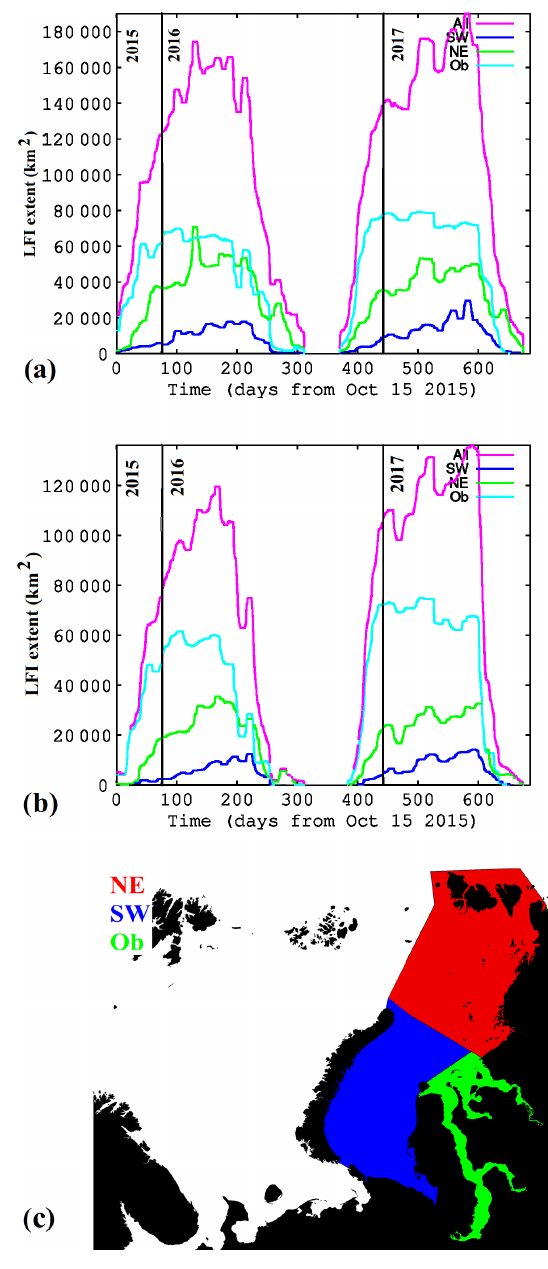
Figure 10. FMI-A (a) and FMI-B (b) LFI time series for the whole study period from 15 October 2015 to 31 August 2017. Also the time series of Kara Sea subregions – southwestern (SW), northeast- ern (NE), and Gulf of Ob (Ob) – have been included. The division of Kara Sea into subregions (c)